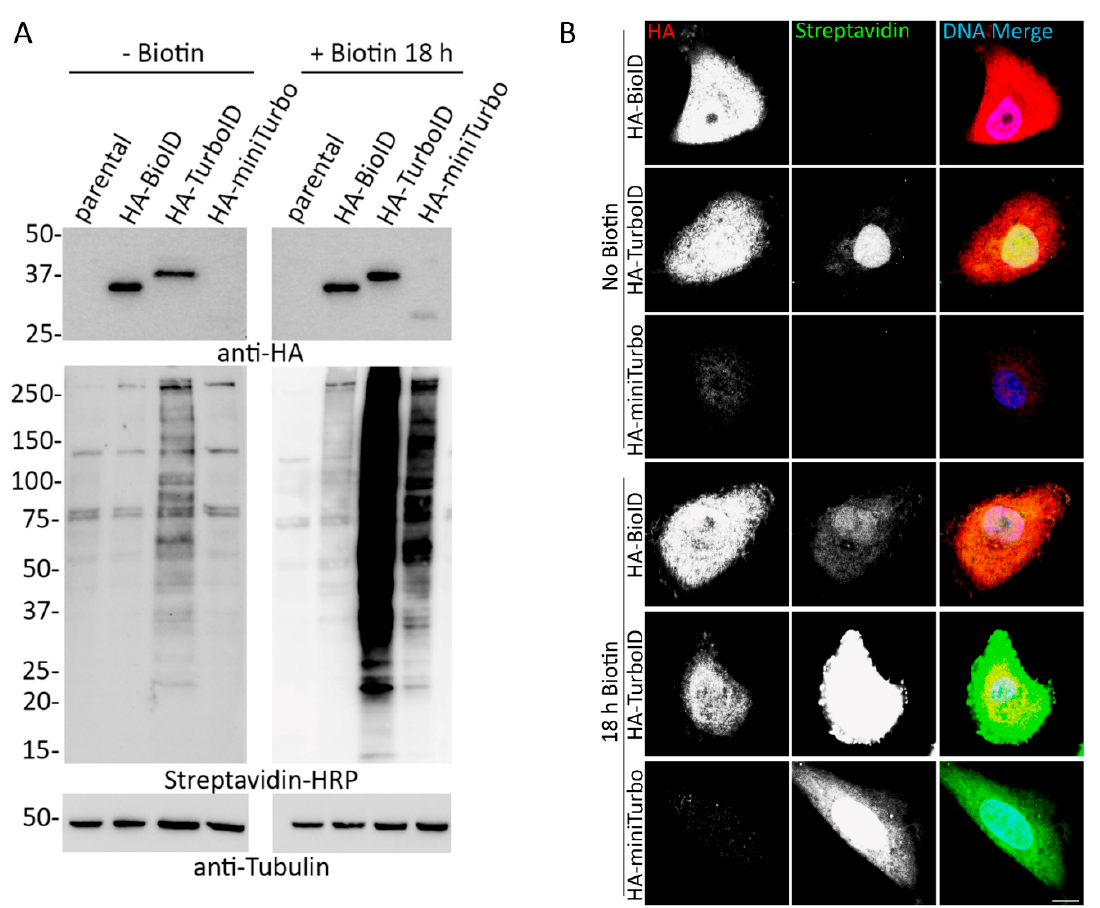
Figure 1. Addition of exogenous biotin increases biotinylation in HA-tagged BioID, TurboID, and miniTurbo expressing cells. ( A ) A549 cell lysates stably expressing HA-tagged BioID, TurboID, or miniTurbo were analyzed via WB in the absence and presence of exogenous biotin (18 h). Anti-HA was used to probe for expression of the ligase and streptavidin HRP was used to probe for biotinylation. Anti-tubulin was used as protein loading control. ( B ) Confocal images of A549 cells stably expressing HA-tagged BioID, TurboID, or miniTurbo with and without the addition of excess biotin for 18 h. Anti-HA was used to visualize ligase localization (red) and fluorescently conjugated streptavidin was used to visualize biotinylation (green). Hoechst dye was used to detect the DNA in the nucleus (blue in merge). Scale bar 10 μ m.